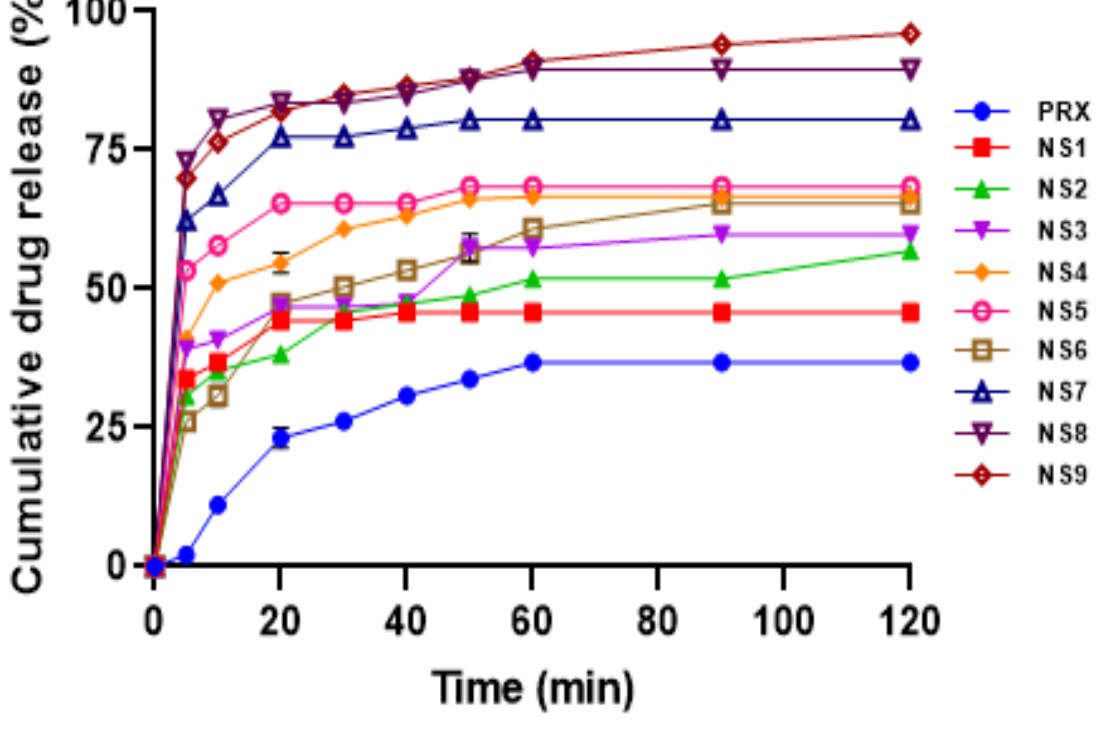
Figure 8. In vitro drug release profiles of prepared PRX NS formulations.